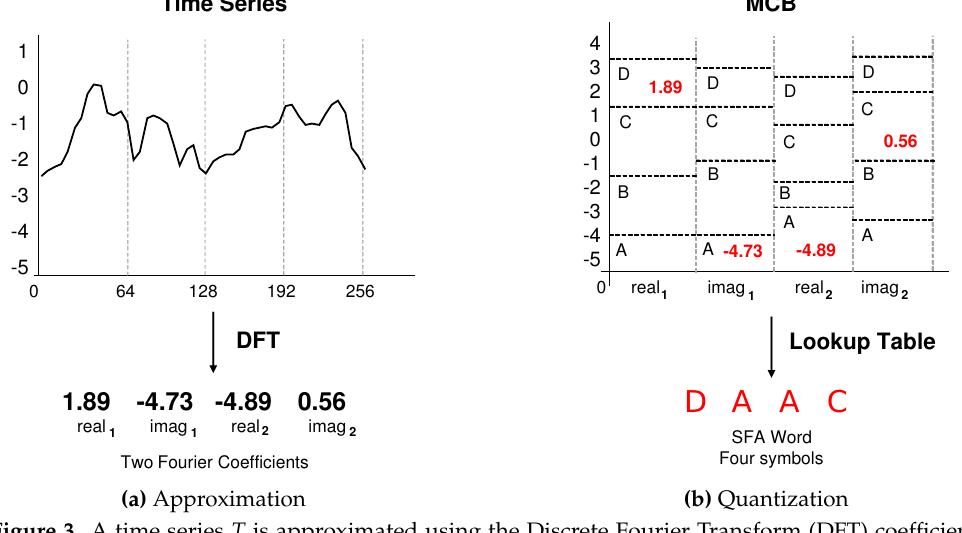
Figure 3. A time series T is approximated using the Discrete Fourier Transform (DFT) coefficients. In the quantization phase, the SFA uses the Multiple Coefficient Binning (MCB) to define the best breakpoints and finally generate the word ‘DAAC’ of size 4 and alphabet of size 6